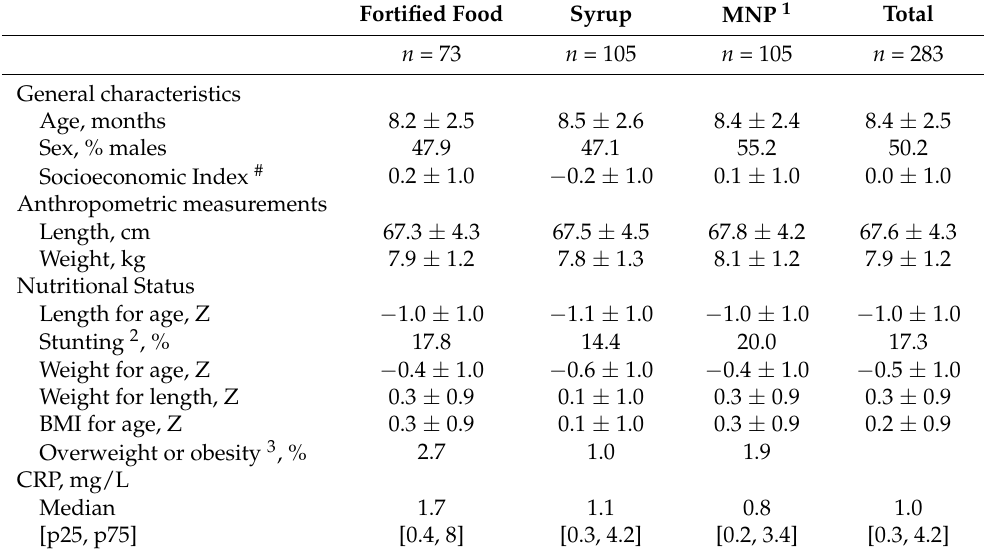
Table 2. Baseline characteristics of the sub-sample of participants with venous blood samples at baseline and after 4 months of supplementation with one of three micronutrient products. Fortified Food Syrup MNP 1 Total n = 73 n = 105 n = 105 n =